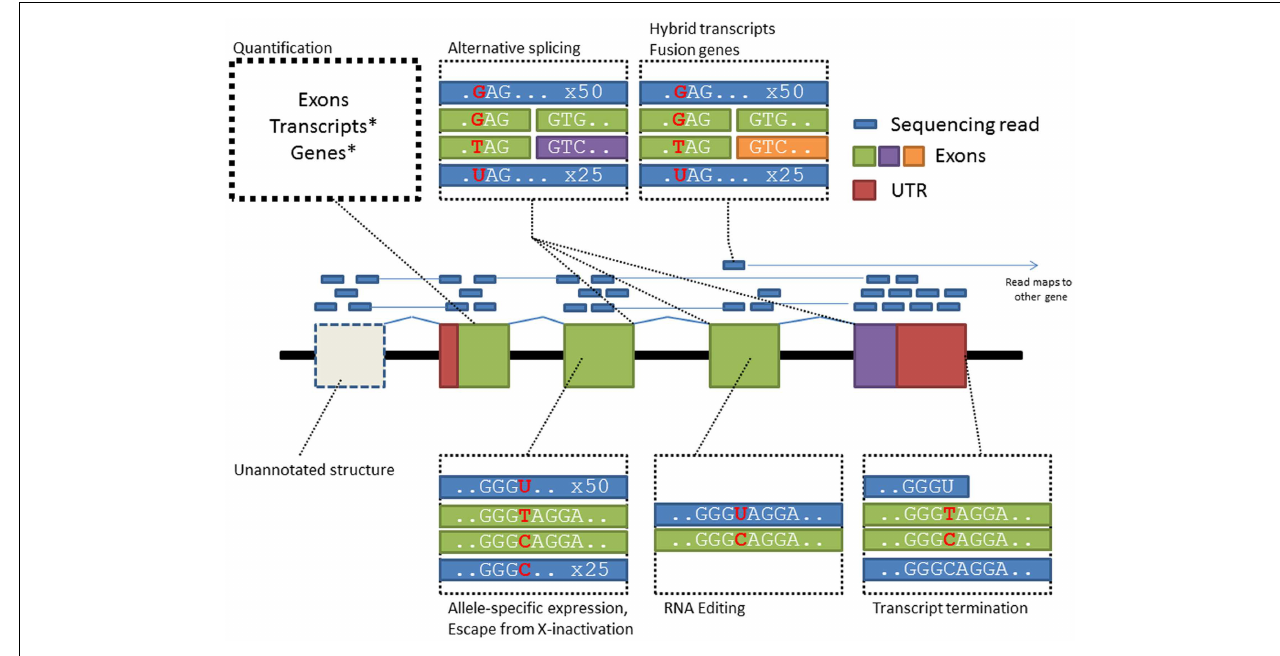
FIGURE 1 | RNA-Seq supports the characterization of diverse transcriptome features providing increased ability for linking trait-predisposing variation to their mode of impact . Each box in this figure highlights a specific-type of biological data that can be assessed from RNA-Seq